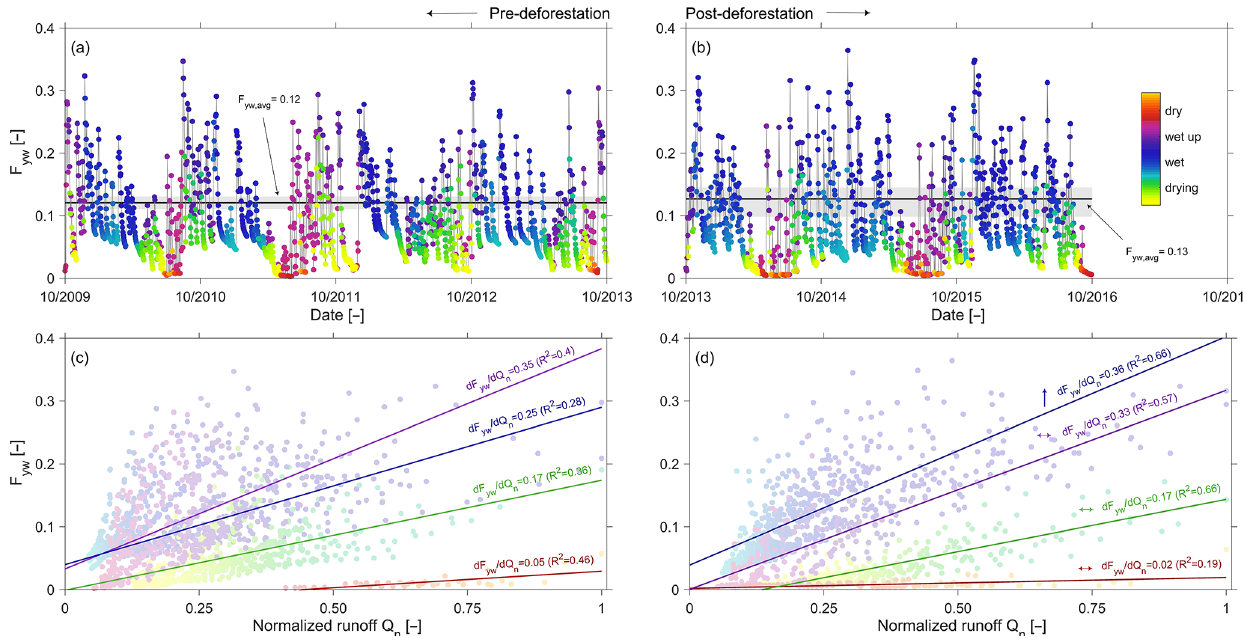
Figure 10. (a, b) Pre- and post-deforestation time series of young water fractions F yw in discharge. The colour code indicates the transition between dry, wetting-up, wet and drying conditions. The bold black line shows the mean F yw of the best model fit, and the grey shaded area shows the 5th / 95th percentile of F yw for all feasible model solutions; (c, d) pre- and post-deforestation sensitivity of F yw to discharge, using the same colour code as above to indicate dry, wetting-up, wet and drying conditions. The arrows in (d) indicate whether there are statistically significant ( ↑ ; p < 0 . 05) changes or not ( ↔ ) in the sensitivities between the post-deforestation period and the pre-deforestation period.